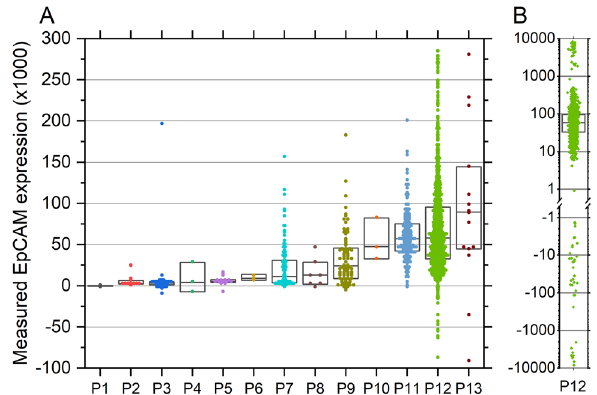
Figure 5. EpCAM expression of CTCs found in leukapheresis products of 13 castration-sensitive prostate cancer patients. ( A ) Expression of CTCs recovered from patients P1-P13 on a linear scale showing a large variation both between patients as well as within a patient. ( B ) Expression of CTCs recovered from patient P12 on a logarithmic scale. Boxes indicate median ± SD. Due to the compensation applied for autofluorescence some cells have attained a negative measured